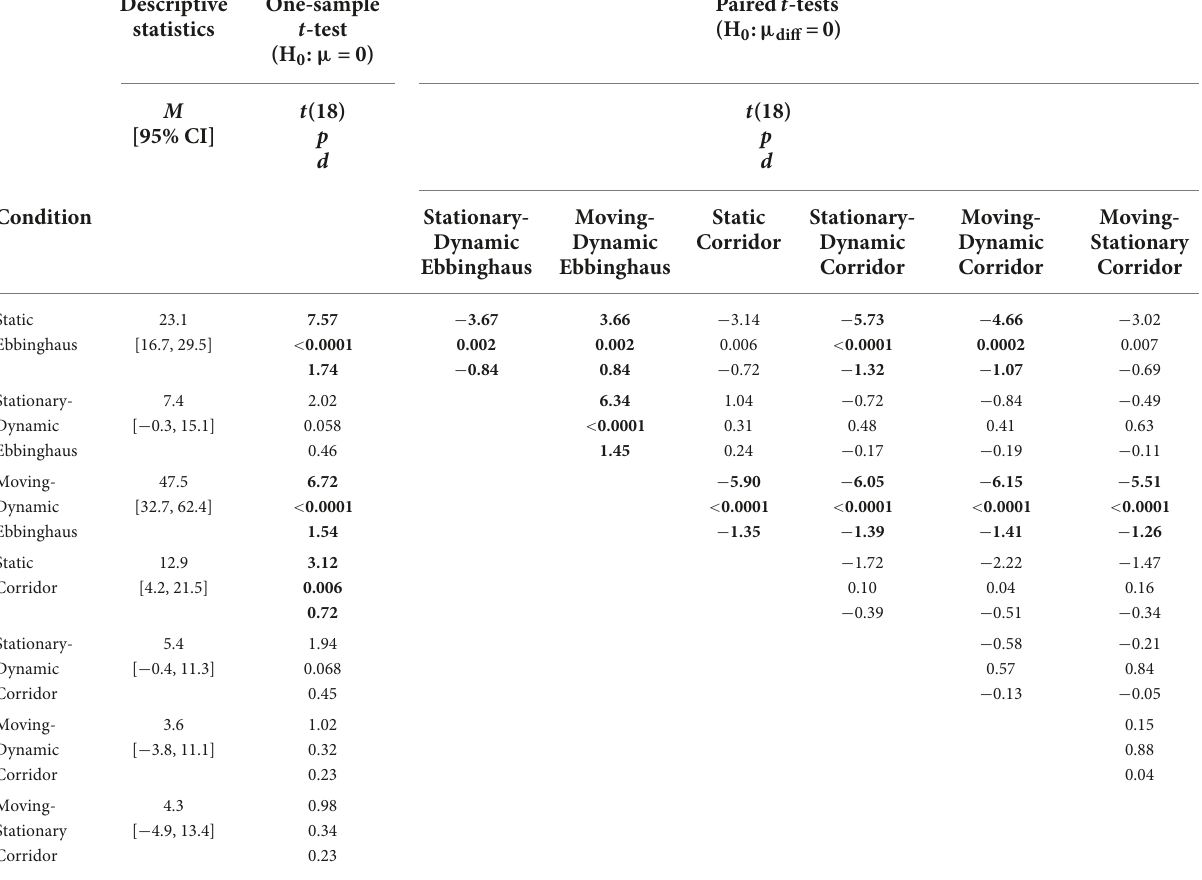
TABLE 1 One-sample and pairwise paired t -tests for all conditions with surrounding context of Experiment 1. Descriptive